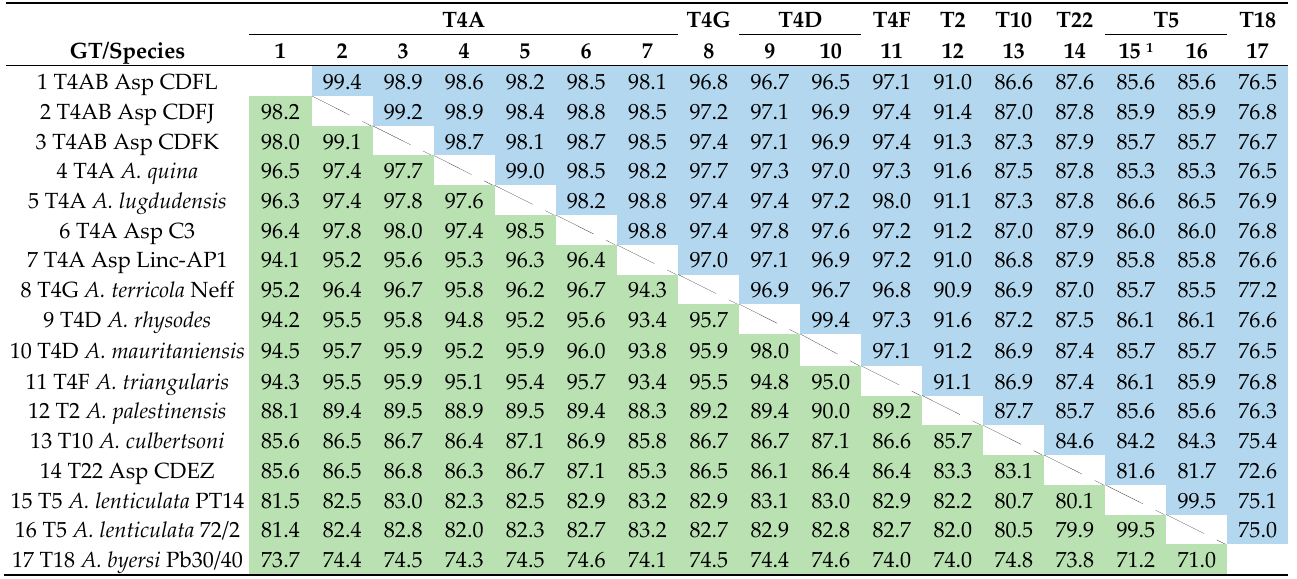
Table 3. Pairwise similarity values (%) for Acanthamoeba full-length 18S (top right, blue) and LSU (bottom left, green) rDNA sequences.